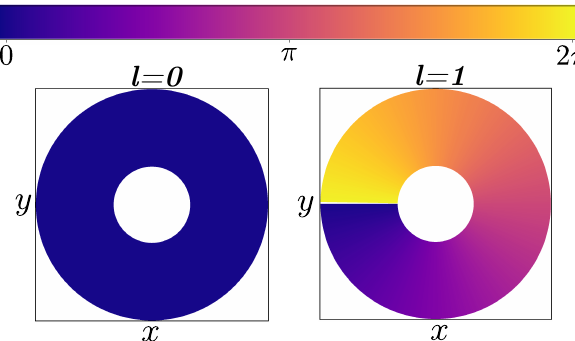
Figure 2: A visualisation of exemplary phase profiles in the z = 0 plane in a toroidal geometry, for quantized circulation states with winding number l = 0 (left) and l = 1 (right). For the l = 1 circulation state, the phase increases by 2 π as it winds around the central hole. The phase is only well defined in the region where there is significant superfluid density, and thus the center of the torus is omitted in this